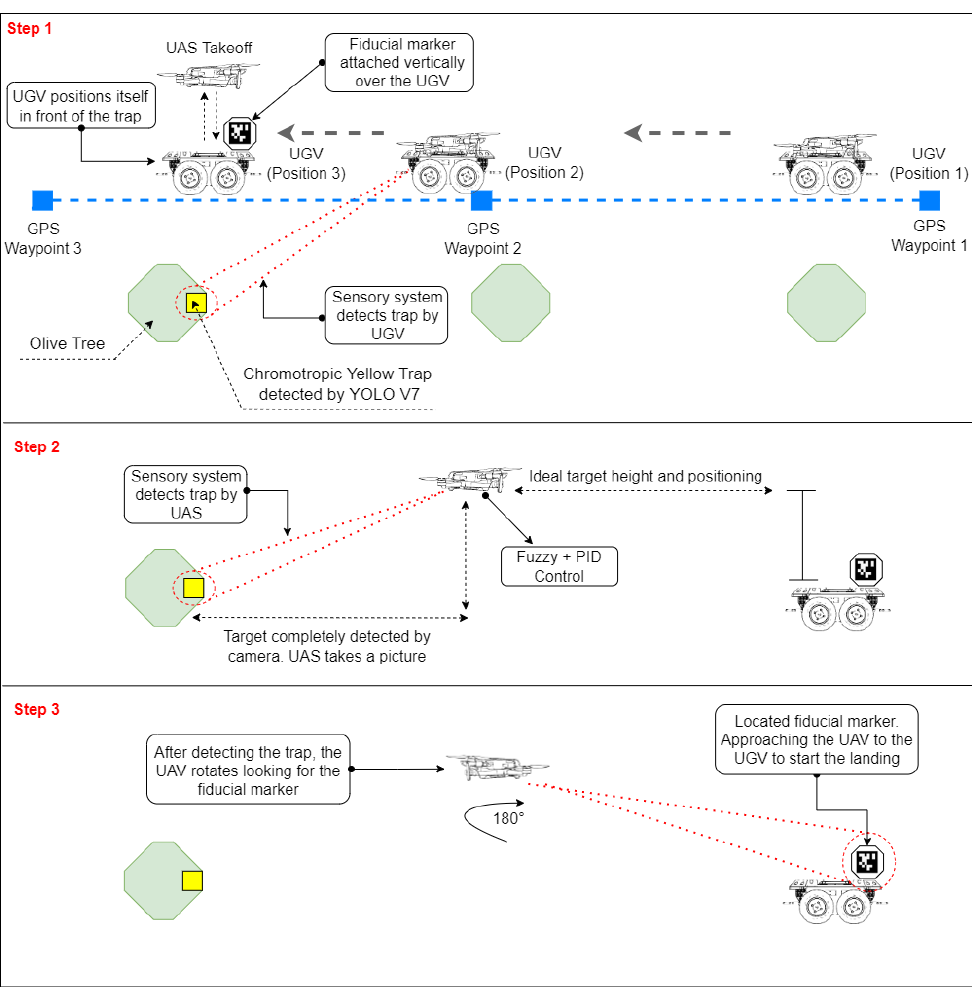
Figure 3. Overview of the proposed